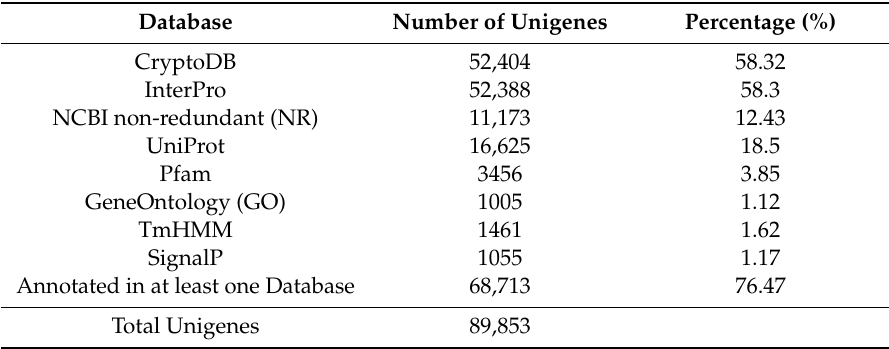
Table 2. Summary of the annotation